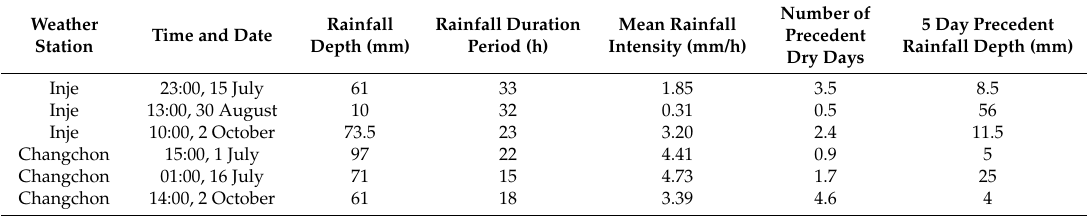
Table 3. Stormwater runoff monitoring for rainfall events in the Lake Soyang watershed in 2016. Weather Time and Date Station